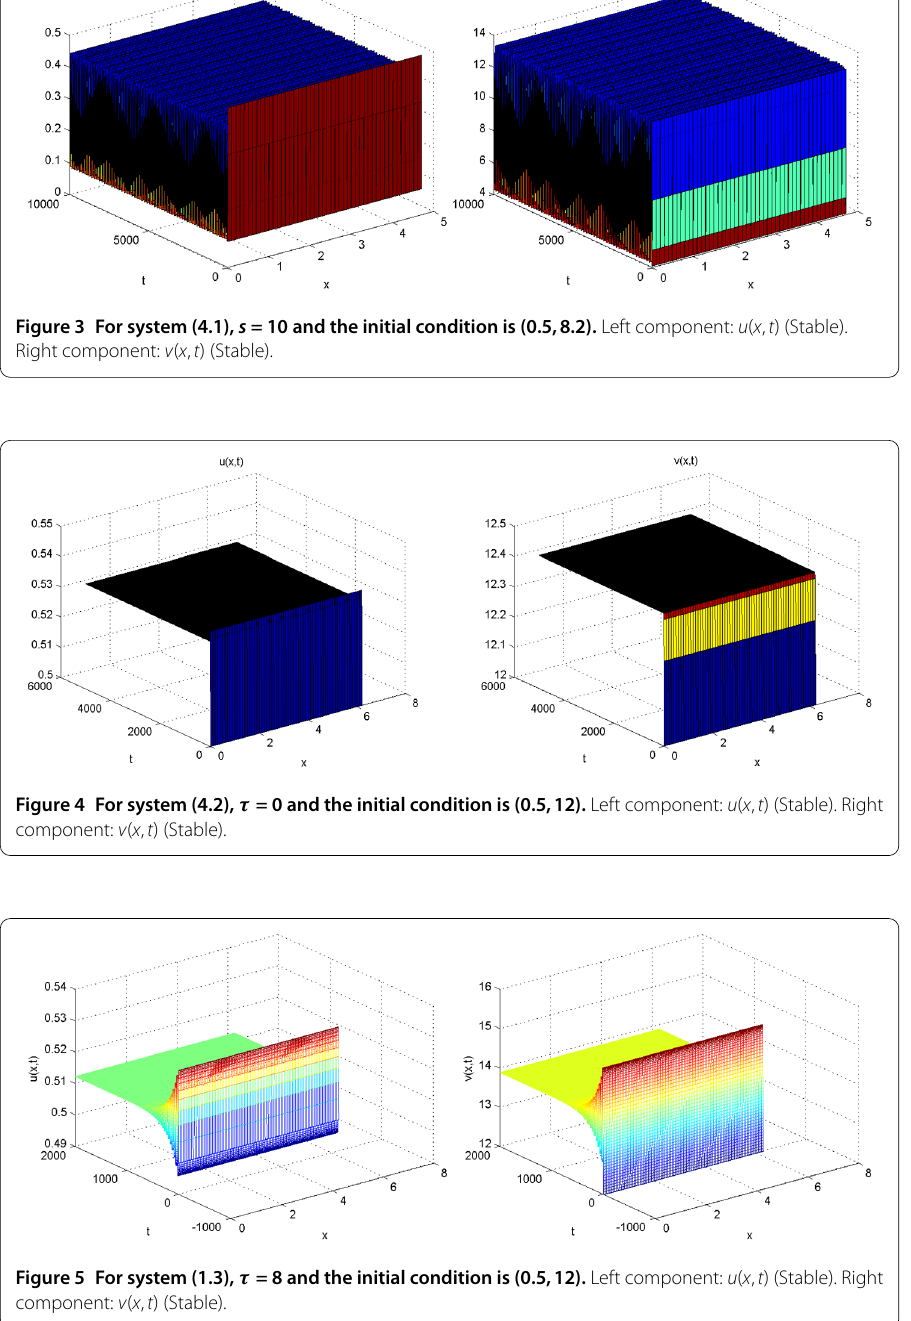
By computation, we obtain τ ∗ ≈ .. By Theorem ., we know that if τ ∈ [, τ ∗ ), then E ∗ ( u ∗ , v ∗ ) is locally asymptotically stable, this is shown in Figure . By Theorem ., Hopf bifurcation occurs at the E ∗ ( u ∗ , v ∗ ) when τ = τ ∗ . By Theorem ., we have μ  ≈ . > , suggesting that the bifurcating periodic solution exists when τ > τ ∗ (shown in Figure